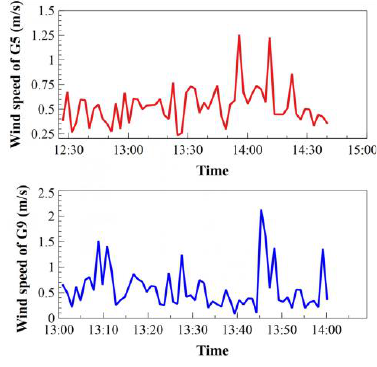
Figure 11. G5 and G9 wind speed data.